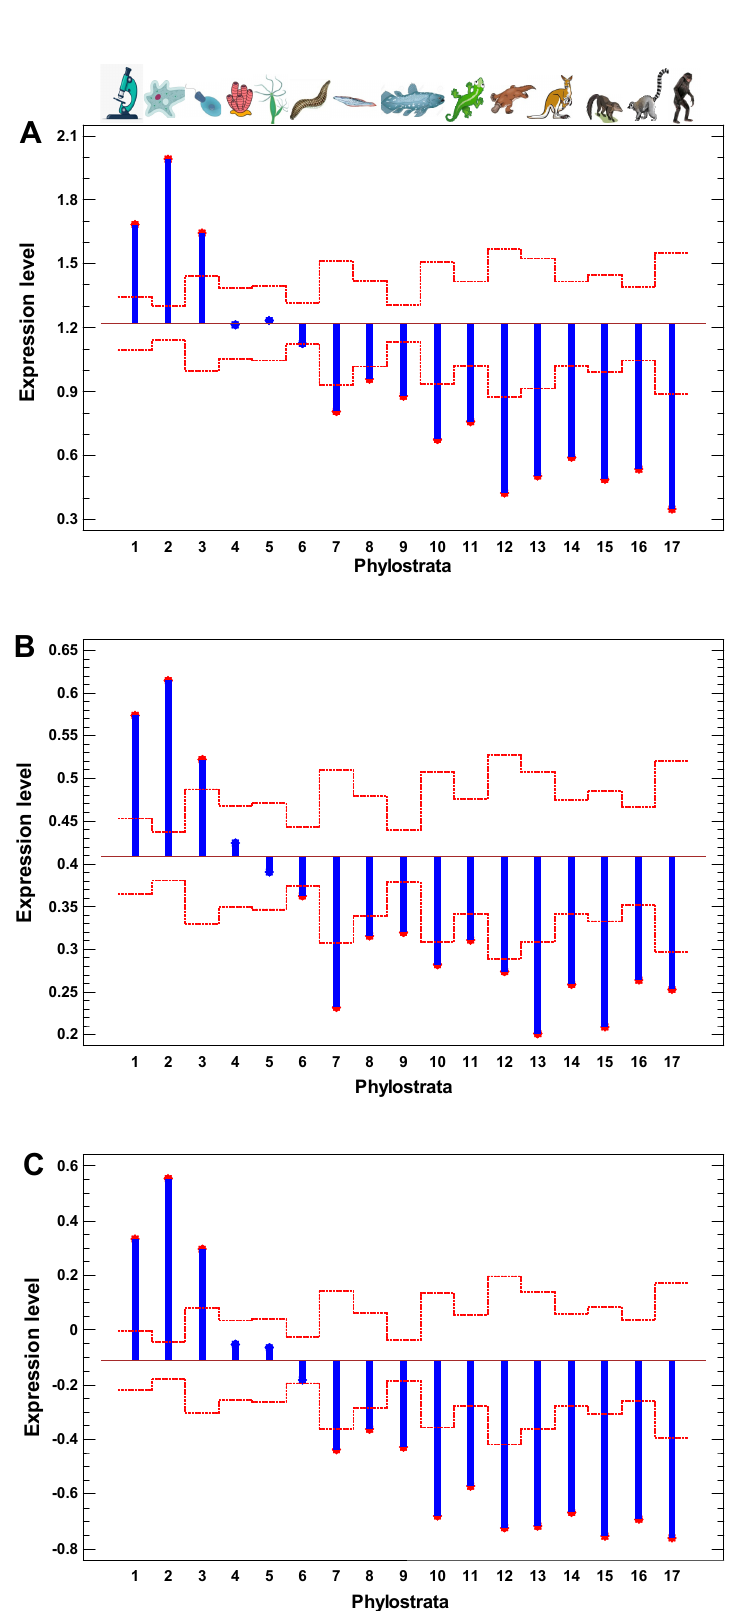
Figure 3. The evolutionary profile of gene expression levels in normal and non-invasive cancer cells. The analysis of means (ANOM) plot showing which phylostrata means are different from the total mean: ( A ) normal cells in the ‘breast cancer’ dataset; ( B ) normal cells in the ‘melanoma’ dataset; ( C ) non-invasive cancer cells in the ‘myeloma’ dataset. Red dotted lines show confidence intervals